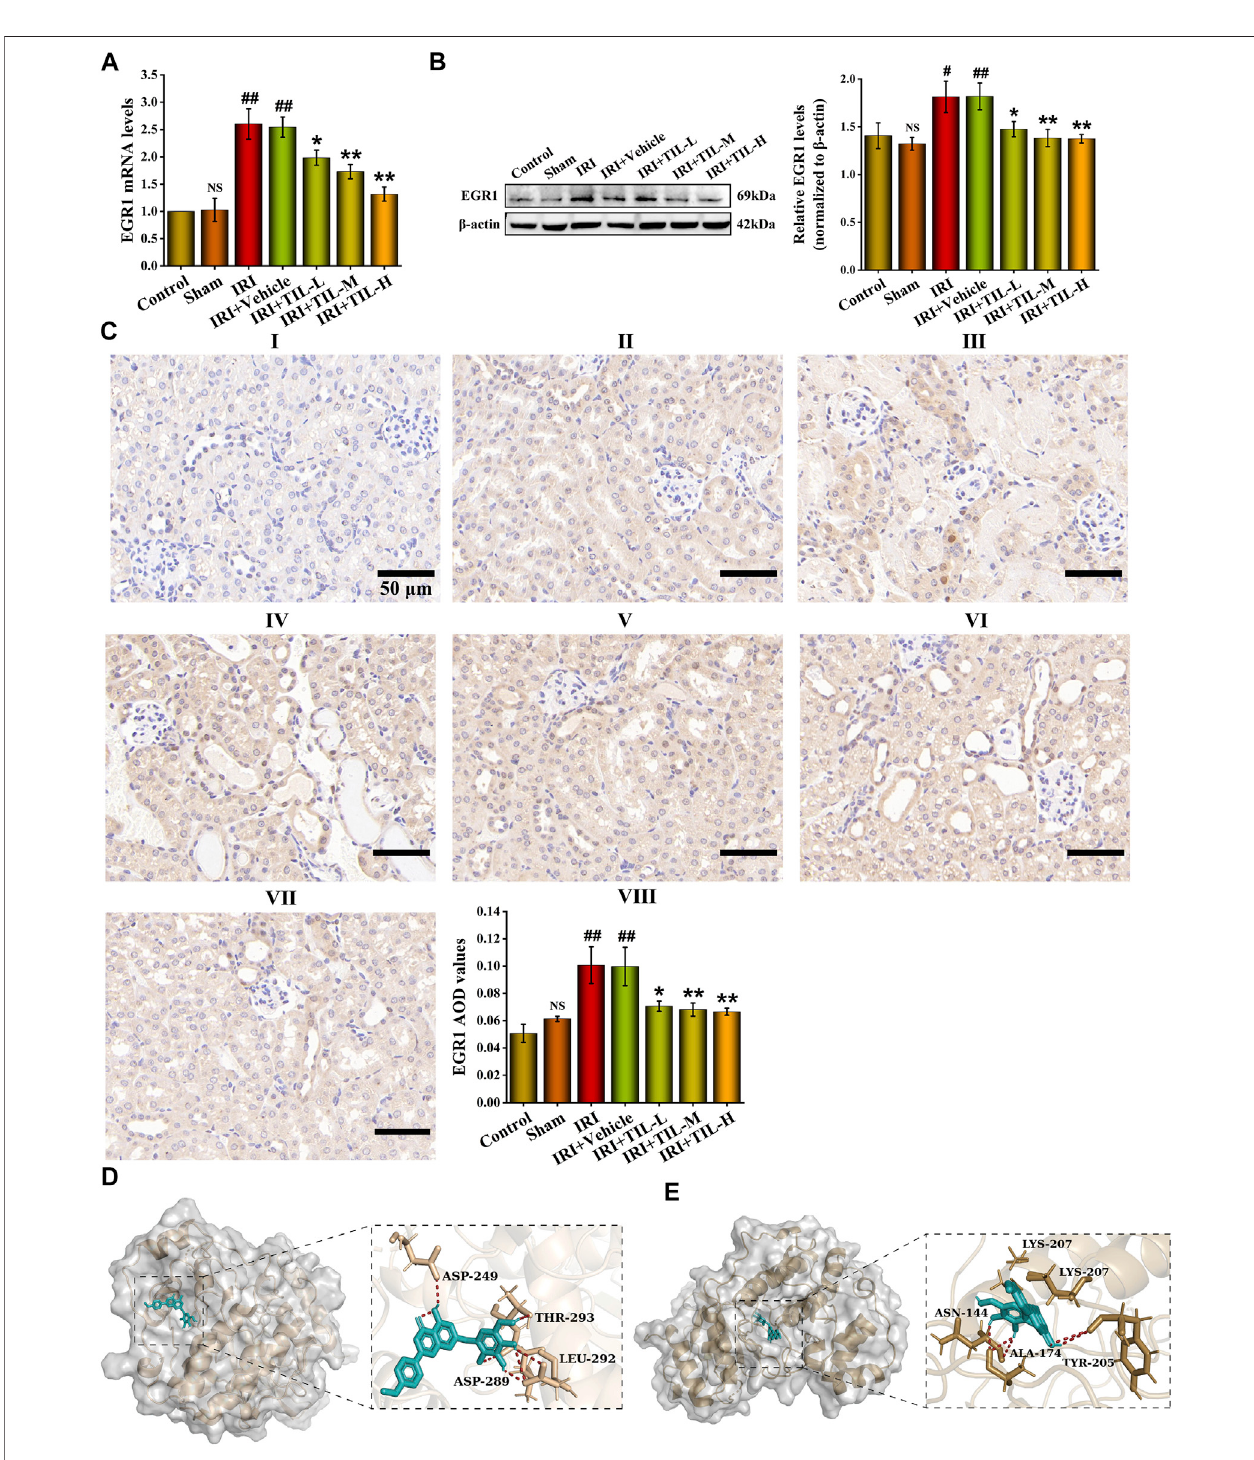
FIGURE 7| Potential of tilianin to regulate the transcriptional activation ofEGR1was found. (A) Relative mRNA levels of EGR1 determined by qRT-PCRin different groups,asindicated. (B) ProteinexpressionandstatisticalresultsofEGR1indifferentgroups,asindicated. n =3pergroup. (C) ImmunohistochemistryimagesofEGR1 under the magni fi cations of 400 × show the location and quanti fi cation of EGR1 in the mouse kidney after I/R-induced AKI. Scale bar, 50 μ m ( Ⅰ : control group; Ⅱ : sham group; Ⅲ : IRI group; Ⅳ : IRI+vehicle group; Ⅴ : IRI+TIL-L group; Ⅵ : IRI+TIL-M group; Ⅶ : IRI+TIL-H group; and Ⅷ : statistical results of EGR1 AOD values). (D,E) Molecular docking visualization results of ERK-tilianin and p-ERK-tilianin. Tilianin is shown as the red stick structure, and the receptors are painted in different colors. Hydrogen bonds are shown as dotted lines, as indicated. All data are shown as mean ± SD. # p < 0.05, ## p < 0.01 versus control ; NS P > 0.05 versus control ; *p < 0.05, **p < 0.01 versus